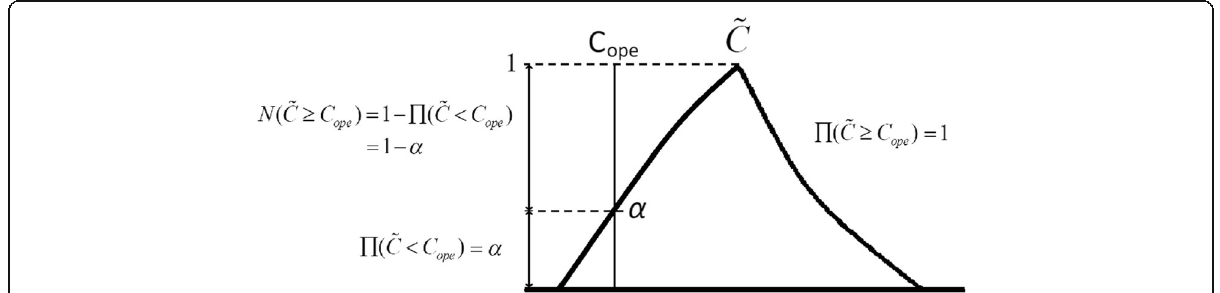
Fig. 4 Fuzzy maximum capacity compared to Operative Capacity, C ope at the left side